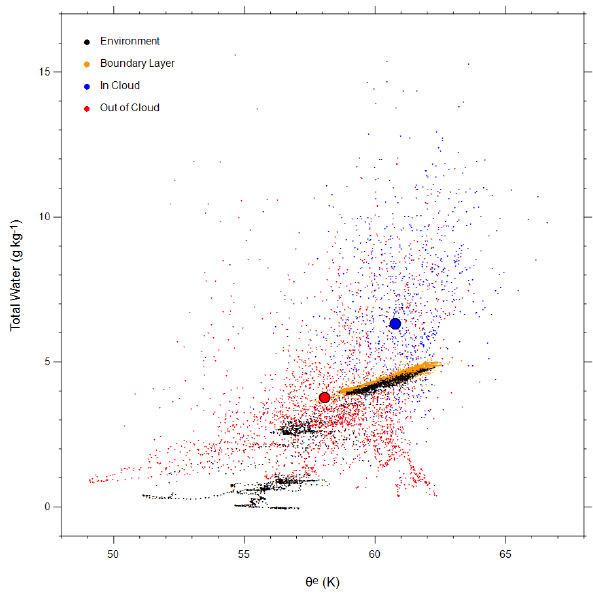
Figure 8. Equivalent potential temperature and total water content during the flight. “Environment” points represent data from the de- scent out of cloud, “Boundary Layer” points represent data col- lected during aircraft ascent to an altitude of 5000m, “In cloud” points represent data collected during aircraft ascent above 5000m where cloud droplet number was measured greater than 0.5cm − 1 and “Out of cloud” points represent data collected during aircraft ascent above 5000m where cloud droplet number was less than 0.5cm − 1 . Mean in- and out-of-cloud values are shown with large circles outlined in